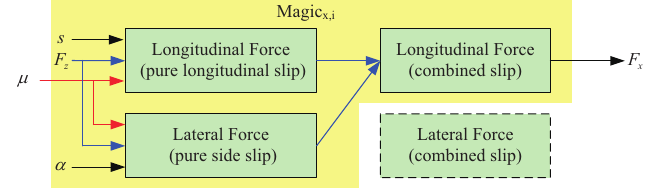
Figure 7. Structure of the Magic